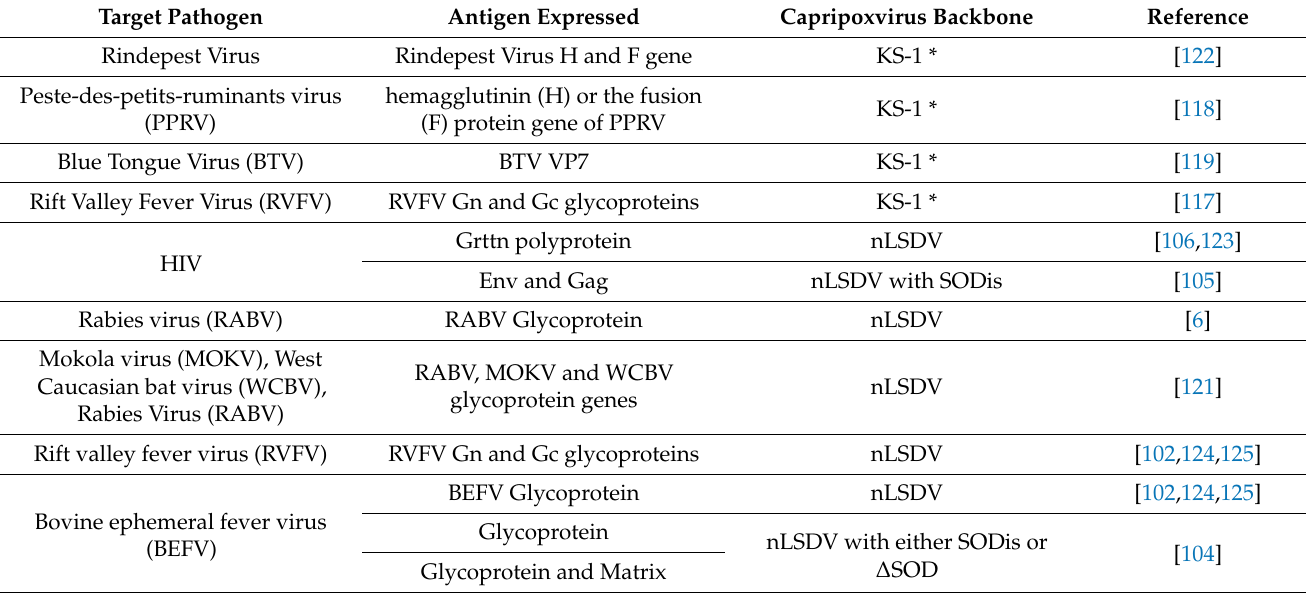
Table 2. Experimental vaccines using Capripoxvirus as a live virus vector. Target